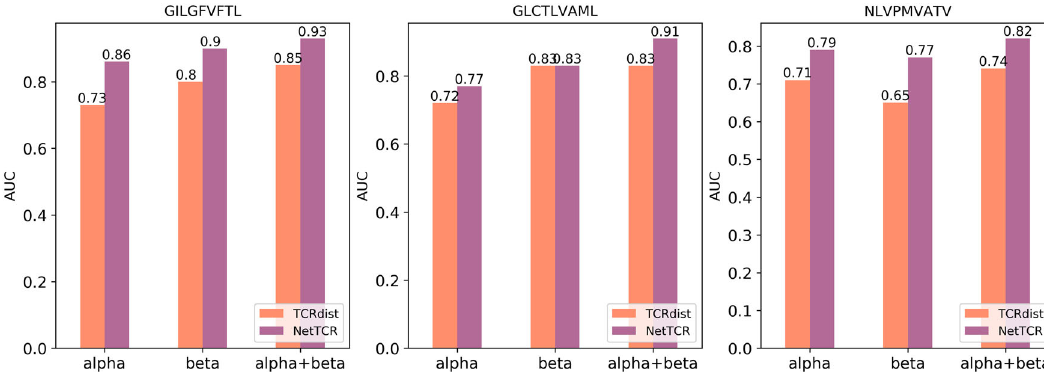
Fig. 4 Comparison between NetTCR and TCRdist. Performance is evaluated via cross-validation on the 95% partitioned data for the three most frequent peptides.